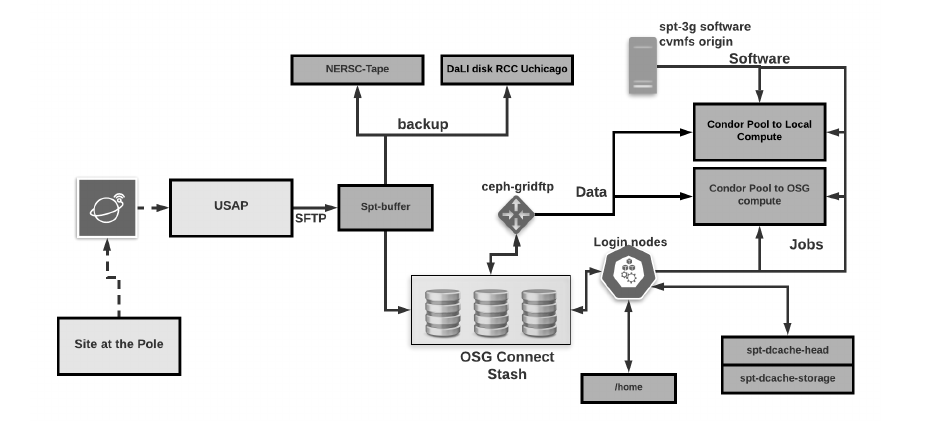
Figure 7. Infrastructure supporting research for the South Pole Telescope collaboration. Data from the instrument at the South Pole are uplinked / downlinked via a satellite to the USAP facility and then transferred to UChicago for processing, backup and